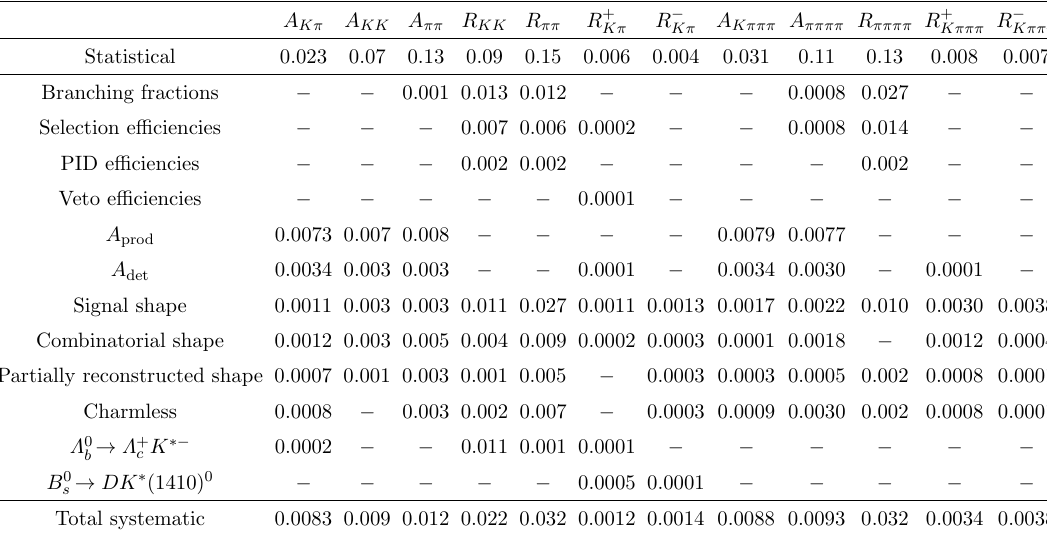
Table 2 . Summary of systematic uncertainties. Uncertainties are not shown if they are more than two orders of magnitude smaller than the statistical uncertainty.